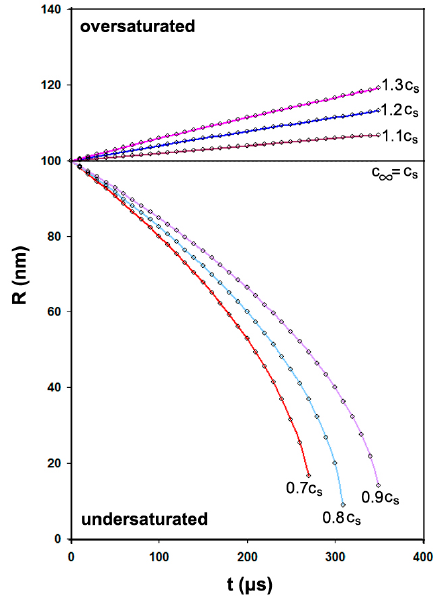
Figure 2. Shrinkage or growth of a bubble of radius 100 nm at various concentrations. Table 1. Dissolution and expansion of different size bubbles at various concentrations.